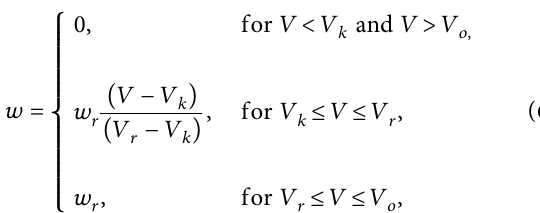
Figure 1: Scheme of the ELD